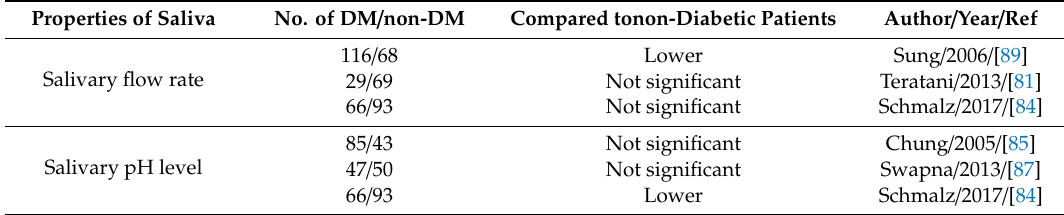
Table 6. Comparison of properties of saliva in diabetic and non-diabetic patients. Properties of Saliva